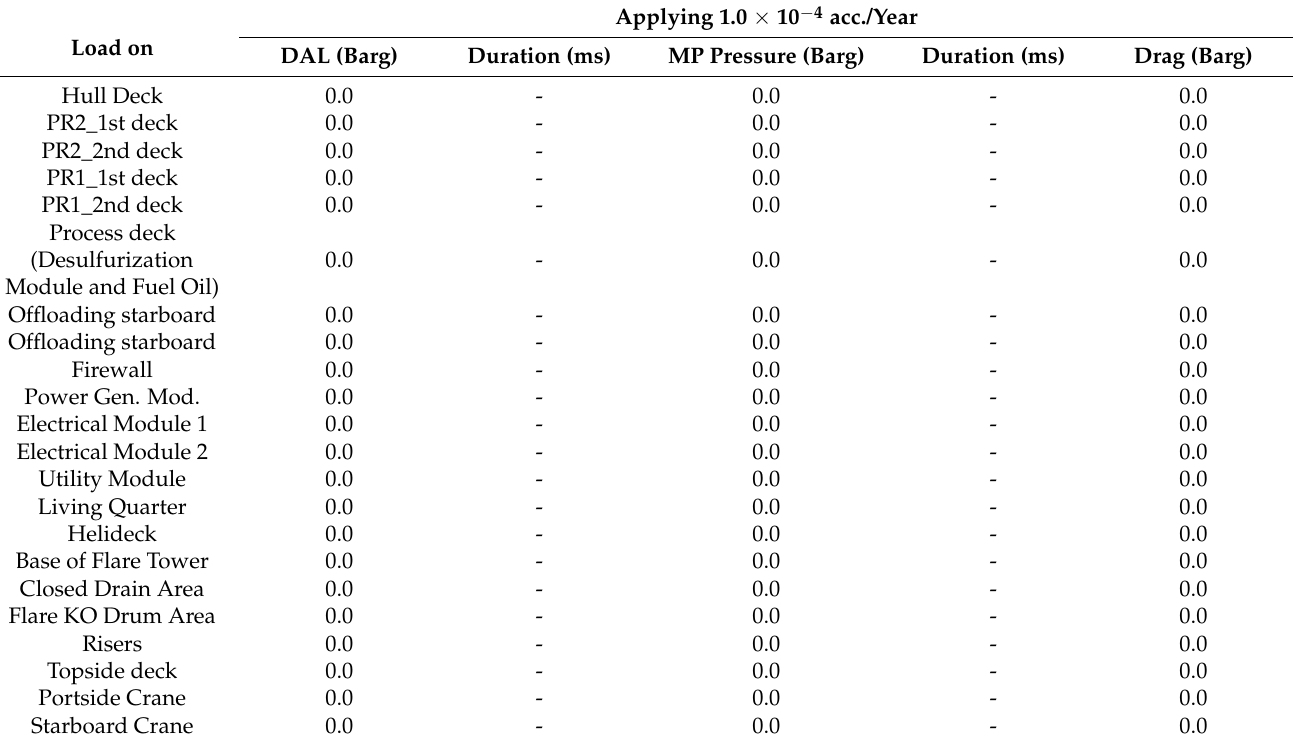
Table 6. Summary of results in terms of the Dimensioning Accidental Loads (DAL), pressure on monitor points, and drag in each